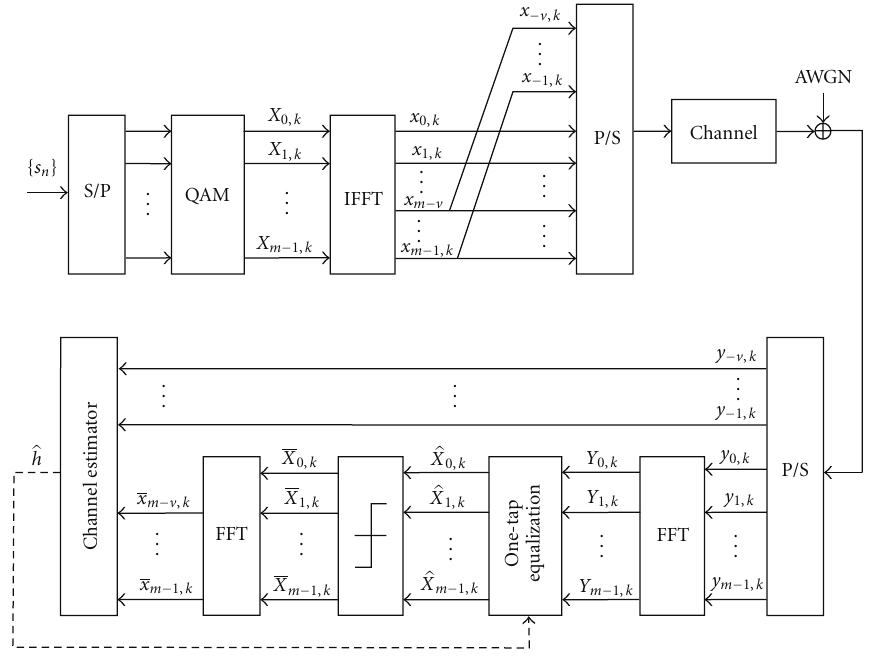
Figure 1: Multicarrier system with CP-based adaptive channel